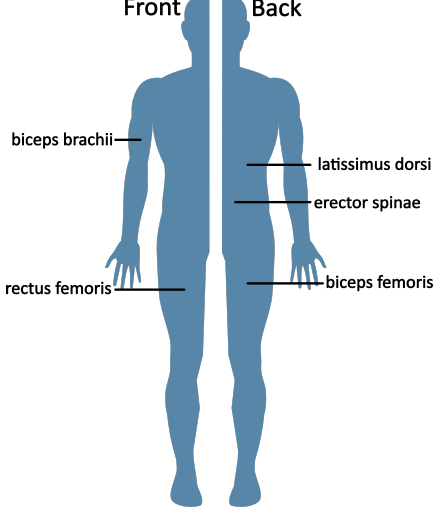
Figure 3. Muscles recorded with EMG sensors.